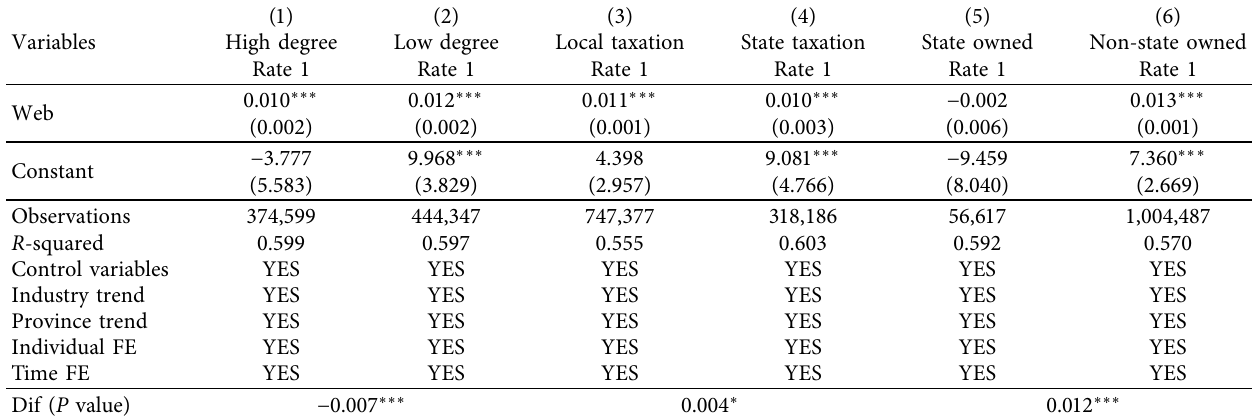
Table 11: Heterogeneity analysis.